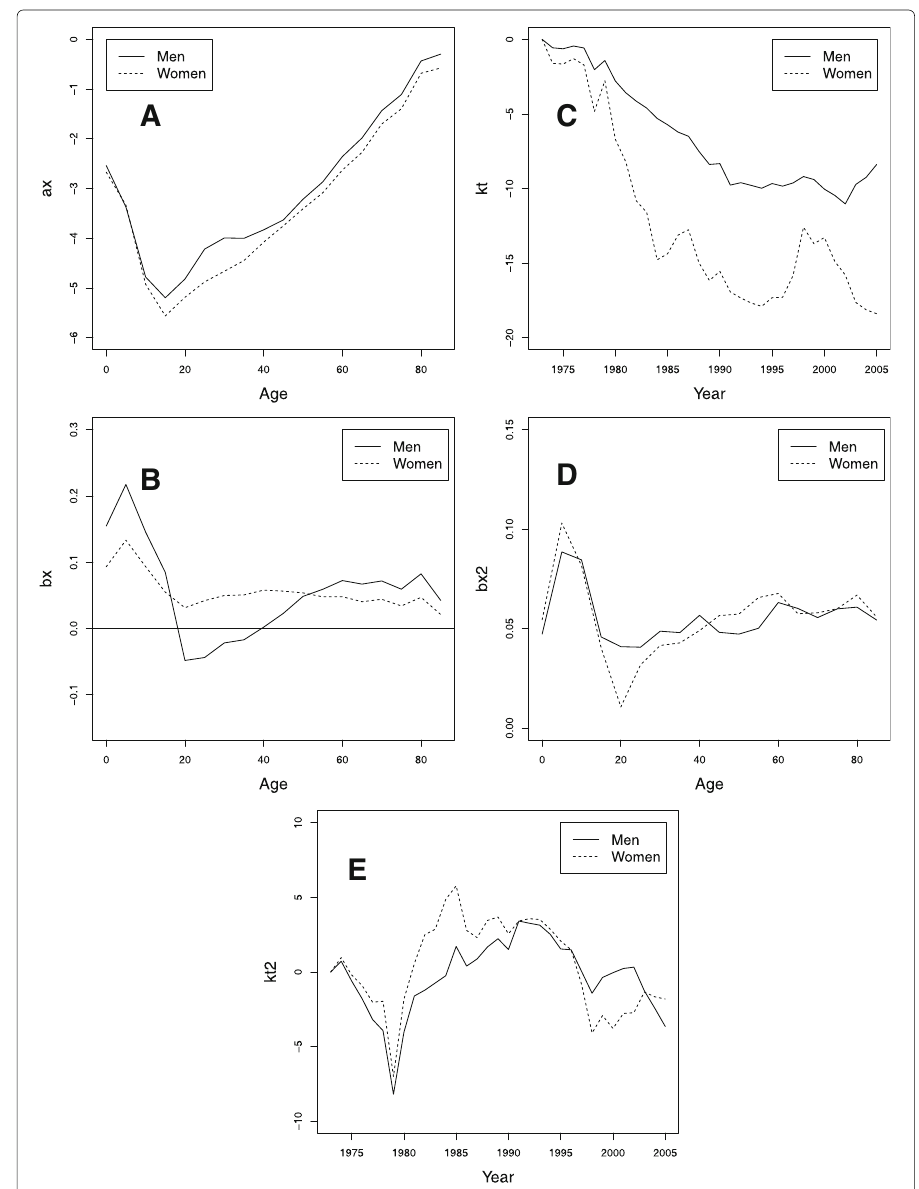
Fig. 6 Parameters for the LC2 model fitted to the Colombian data for the period 1973–2005, men (solid line) and women (dotted line). a a x . b b x . c k t . d b 2 x . e k 2 t